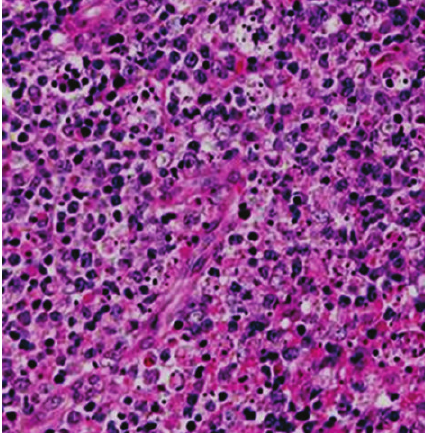
Figure 2: Hematoxylin and eosin stain showing central apoptotic cellular debris surrounded by histiocytes, crescentic immunoblasts, and plasmacytoid monocytes ( ×